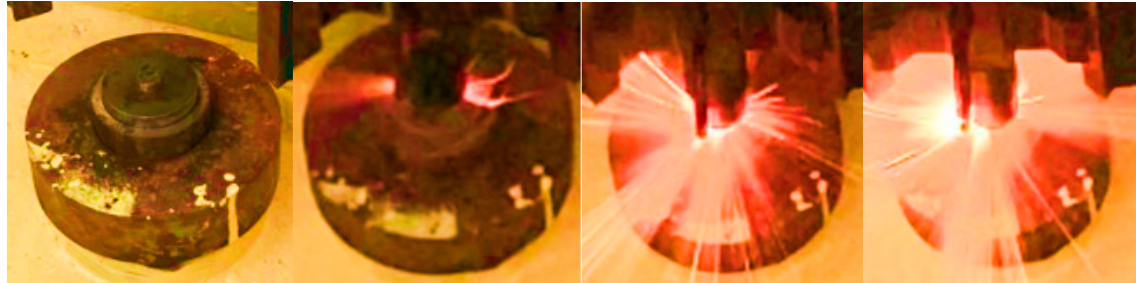
Figure 13. Reactions developed by the composite formulations during impact tests.